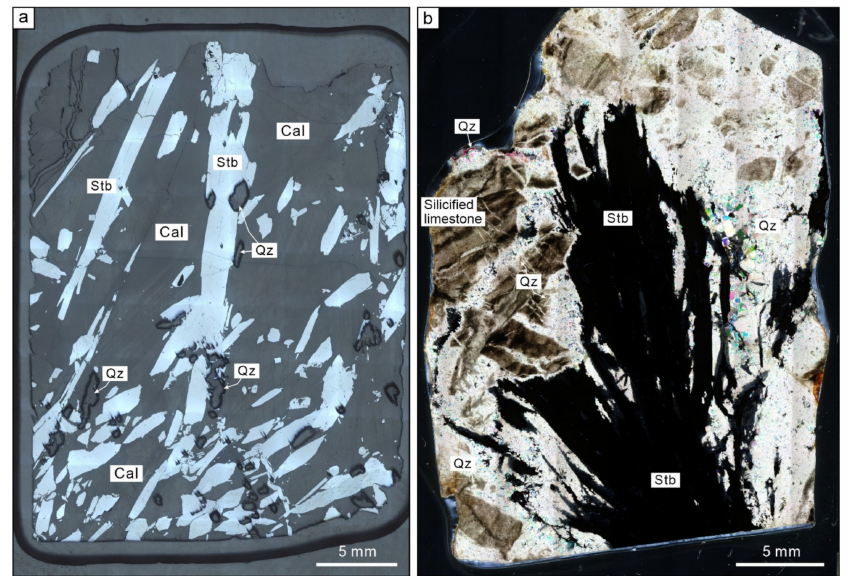
Figure 4. Representative thin section images of Sb ores. ( a ) Photomicrograph of calcite-stibnite vein under reflected light. ( b ) Photomicrograph of quartz-stibnite vein under plane-polarized light. Abbreviations as in Figure